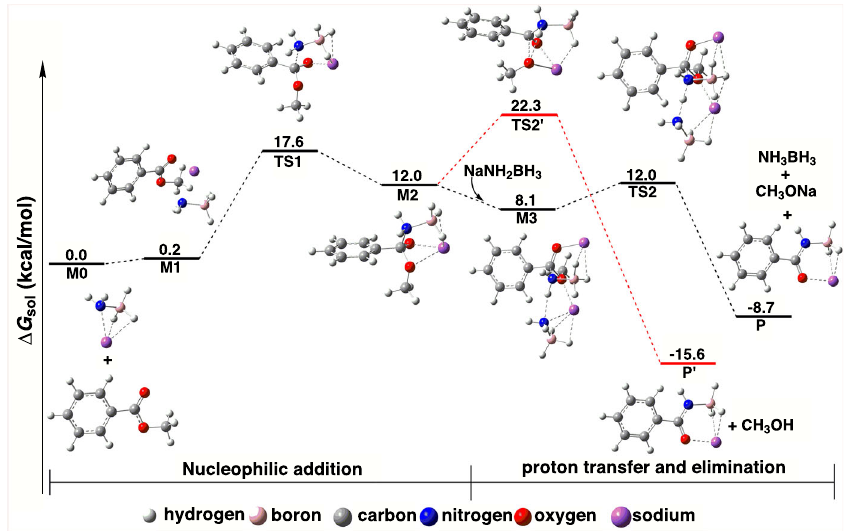
Fig. 4 The reaction mechanism of methyl benzoate with NaAB with computed Gibbs free energy pro fi le. White, H; orange, B; grey, C; blue, N; red, O; purple, Na.